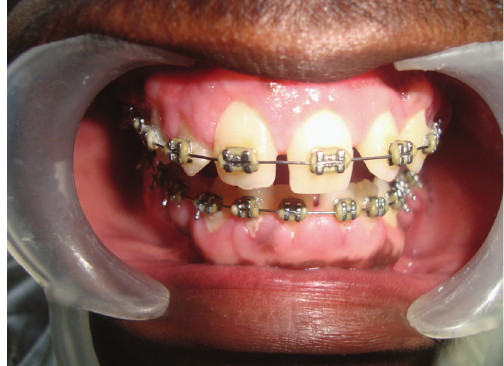
Figure 4: Orthodontic treatment showing excellent improvement after 10 months.